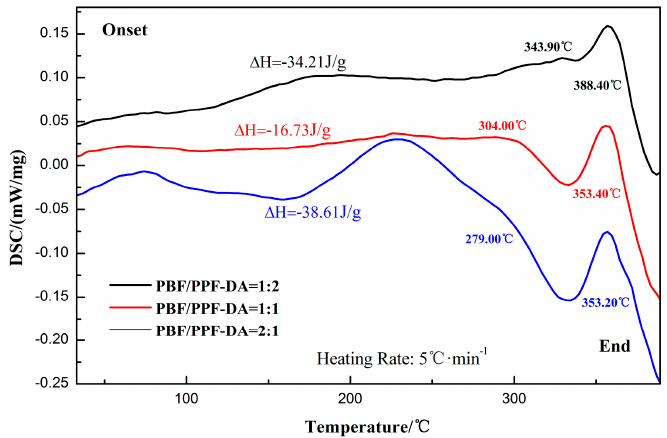
Figure 5. Differential scanning calorimetry (DSC) heating curves for the PBF/PPF-DA polymer networks with double-bond ratios 0.5, 1 and 2. networks with double-bond ratios 0.5, 1 and